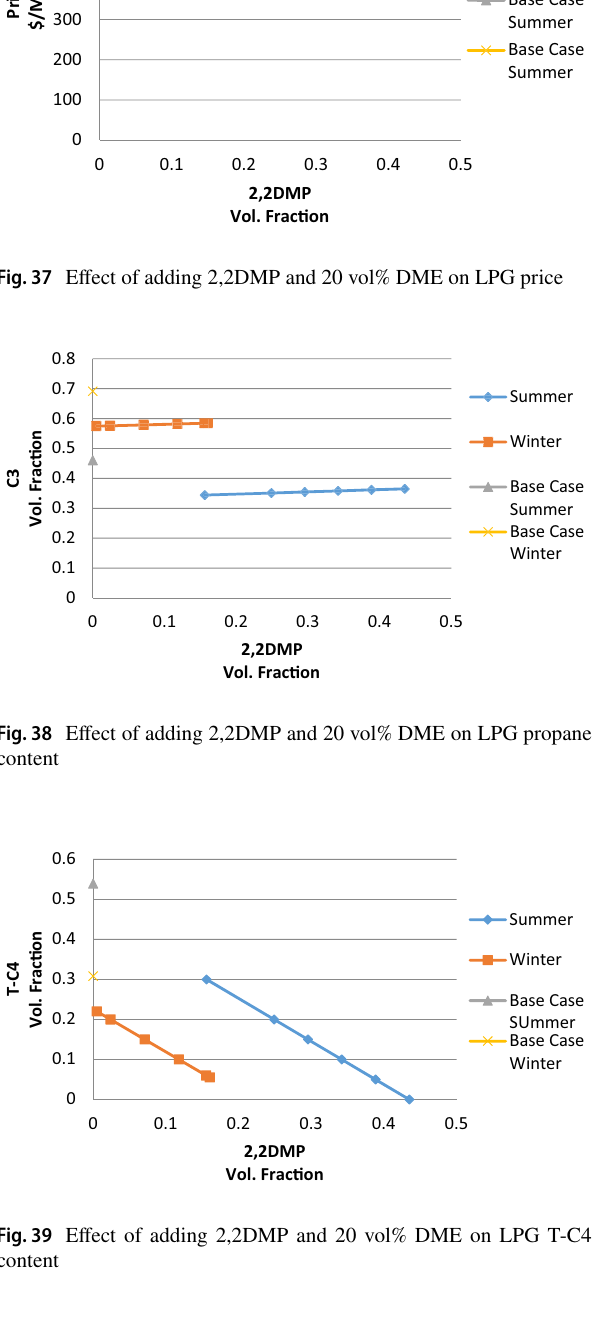
vol% DME and LPG. LPG price increases by 26.3% in winter case and by 35% in summer case.